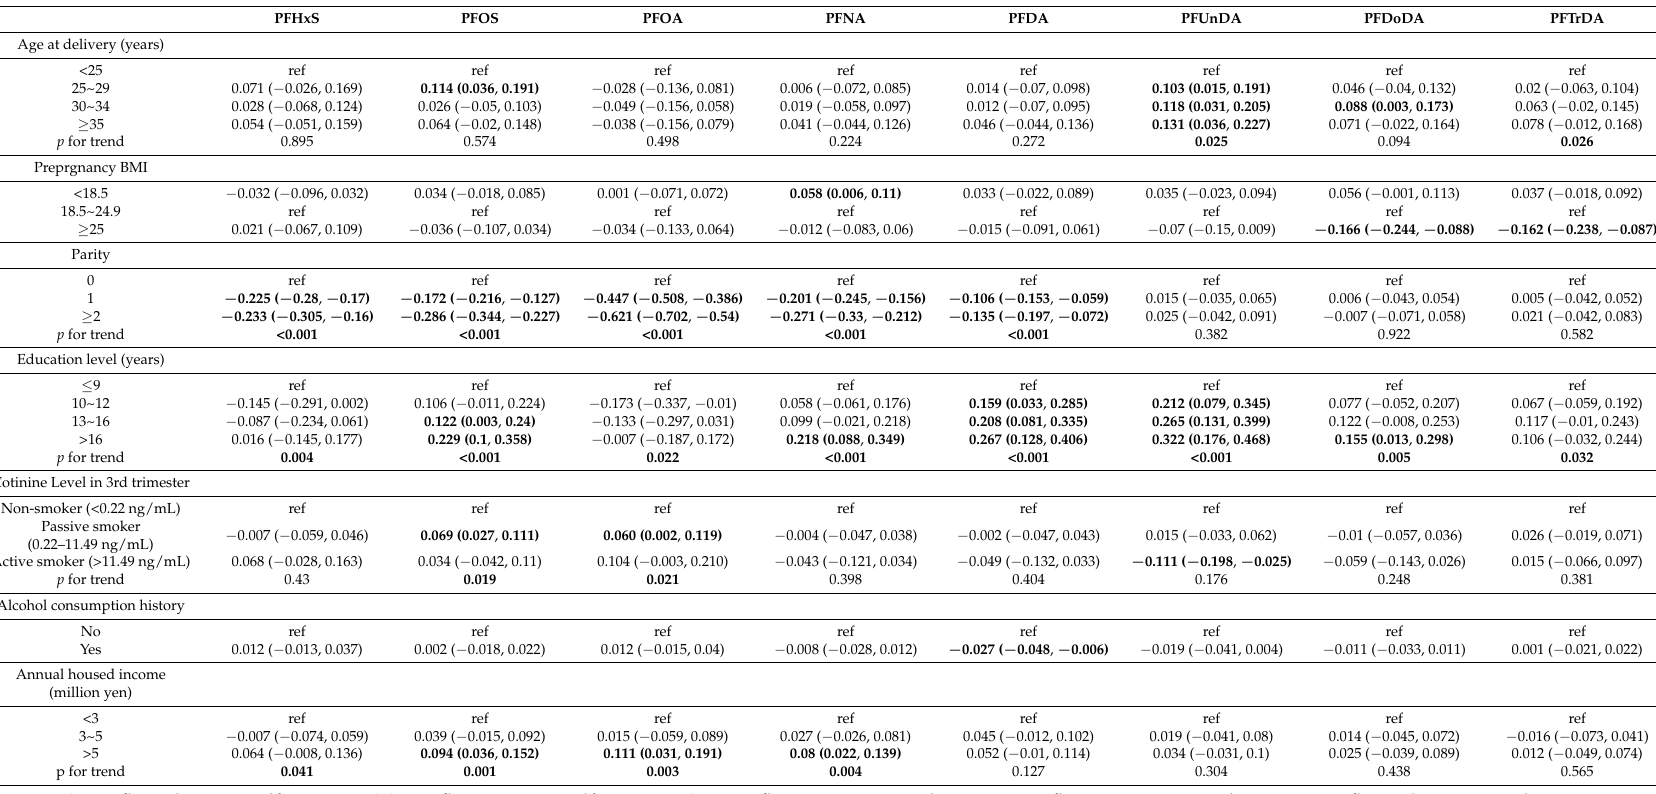
Table 4. Adjust regression coefficients ( β ) and 95% confidence intervals in multivariable linear regression model by PFAS in pregnant